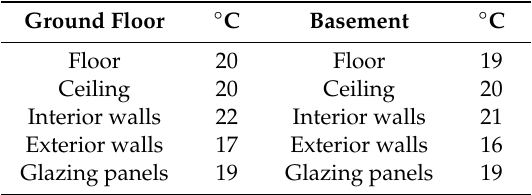
Table 3. The meteorological data at the time of measurement were: humidity 87%, wind speed 5 km / h, ◦ ◦ sensation temperature 10 C, outdoors temperature 15 C. Infrared thermometer and thermocouple type K sensor were used with ± 0.2% accuracy. Table 3. Temperature profiles measured at the ground floor and at the basement at the green and smart house